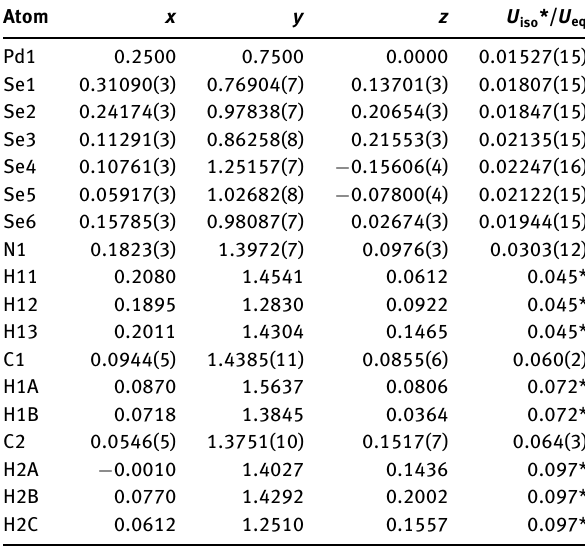
Table 2: Fractional atomic coordinates and isotropic or equivalent isotropic displacement parameters (Å 2